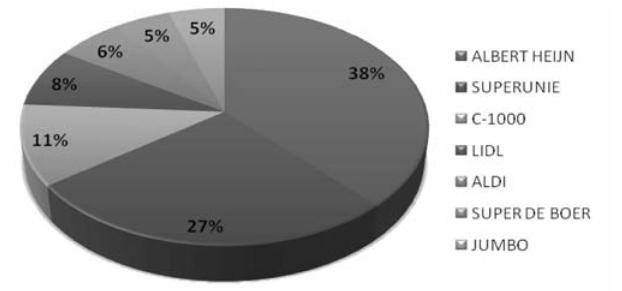
Table 12. Supermarket Sales canned fruit ( € x